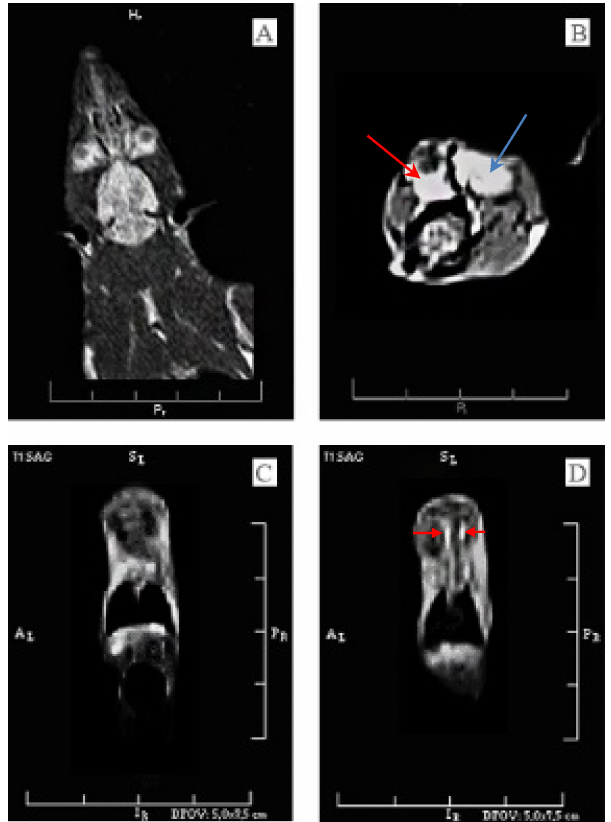
Fig. 1. The typical example of common type of stress- induced hemorrhages in the brain of adult (on the top) and newborn (on the bottom) rats: A and C — MRI imaging of normal brain tissues; B and D — the intensive MRI signals show the hemorrhagic impregnation of the brain tissues; B — the hemorrhages in cerebellum (blue arrow) and cerebellar nucleus (red arrow); D — small hemorrhages in the brain cortex